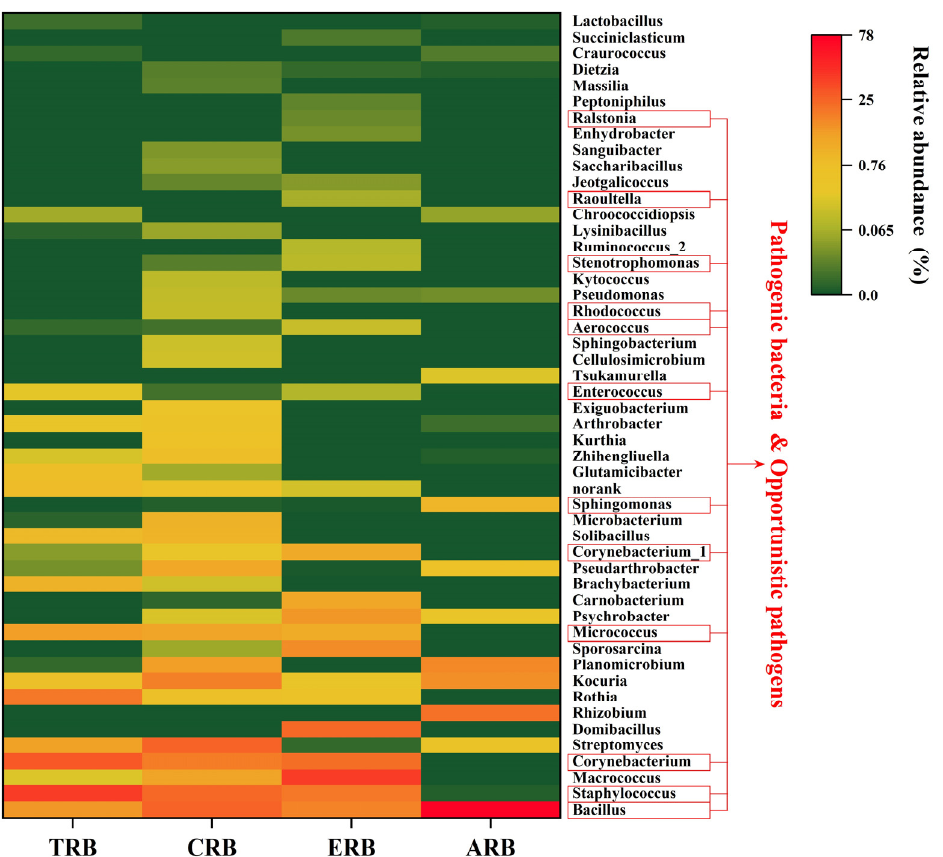
Figure 5. The diversity and relative abundance of the top 50 bacterial genera of four antibiotic-resistant bacteria.